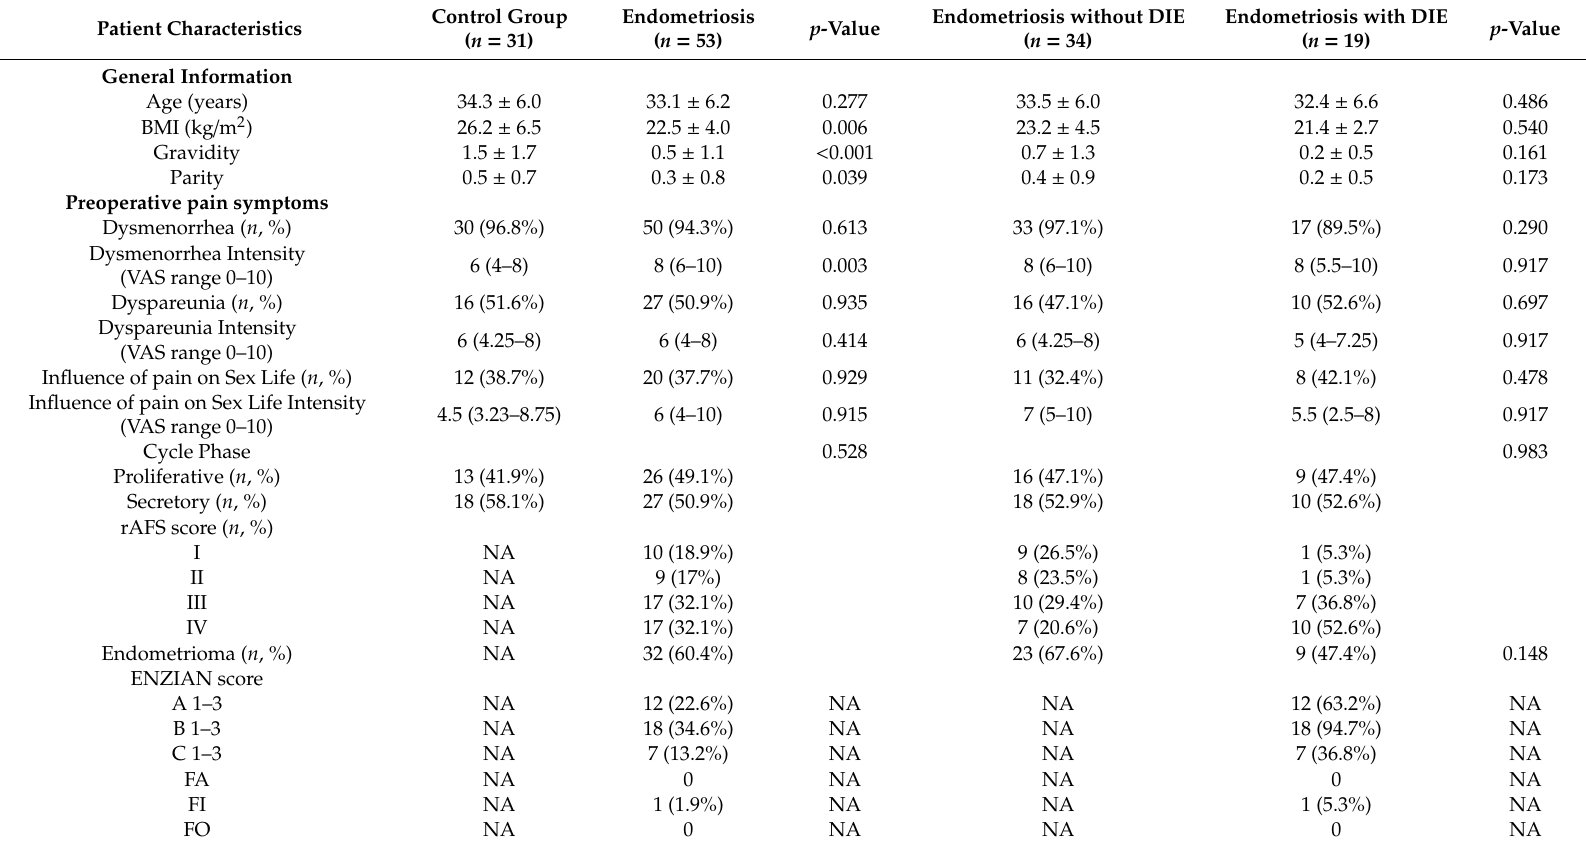
Table 1. Patient